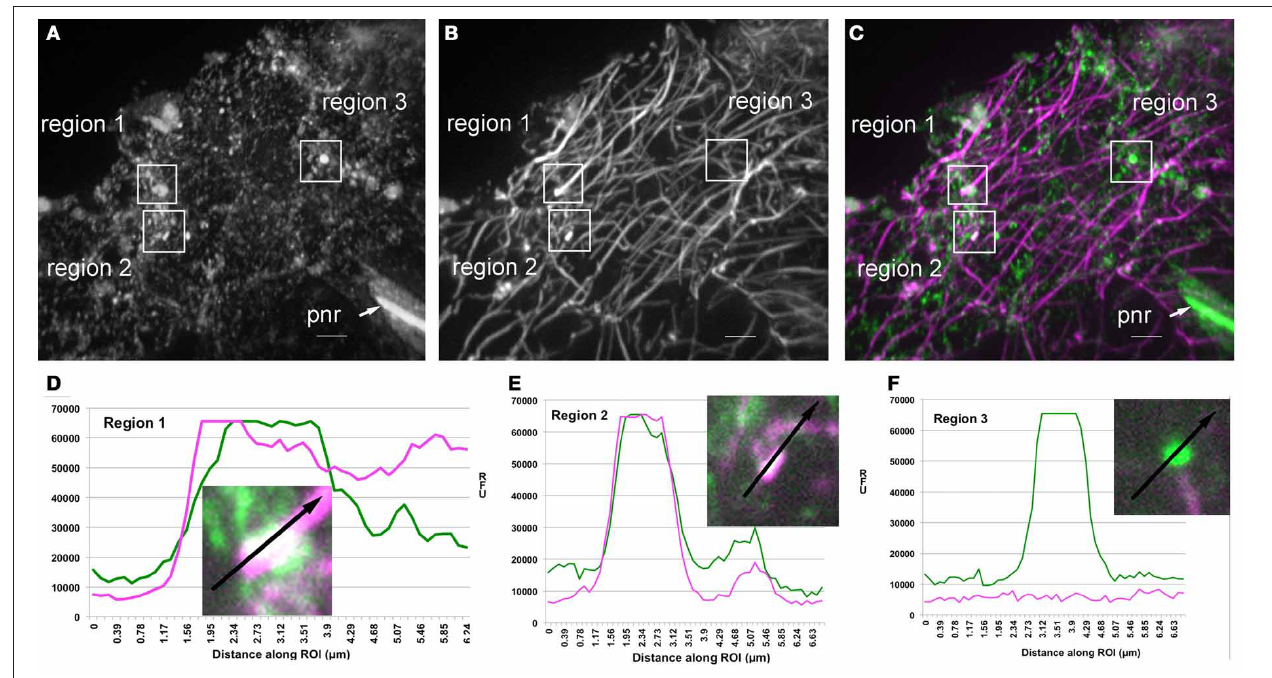
FIGURE 6 | Partial colocalization of ARP2/3 with microtubules and putative microtubule fragments in leaf pavement cells. (A–C) Single channel and image overlay projections of confocal images of ARP2/3 and tubulin signal in a leaf pavement cell. For (A–C) a standard deviation projection method was used on 40 image planes to provide an overview of the regions that are highlighted in (D–F) . Colocalization analysis was performed exclusively within single image planes. (A) Anti-ARPC4:HA signal. (B) Anti- α -tubulin. (C) Overlay of ARPC4:HA (green) and tubulin (magenta) signals. Regions of interest that were analyzed for signal quantification in